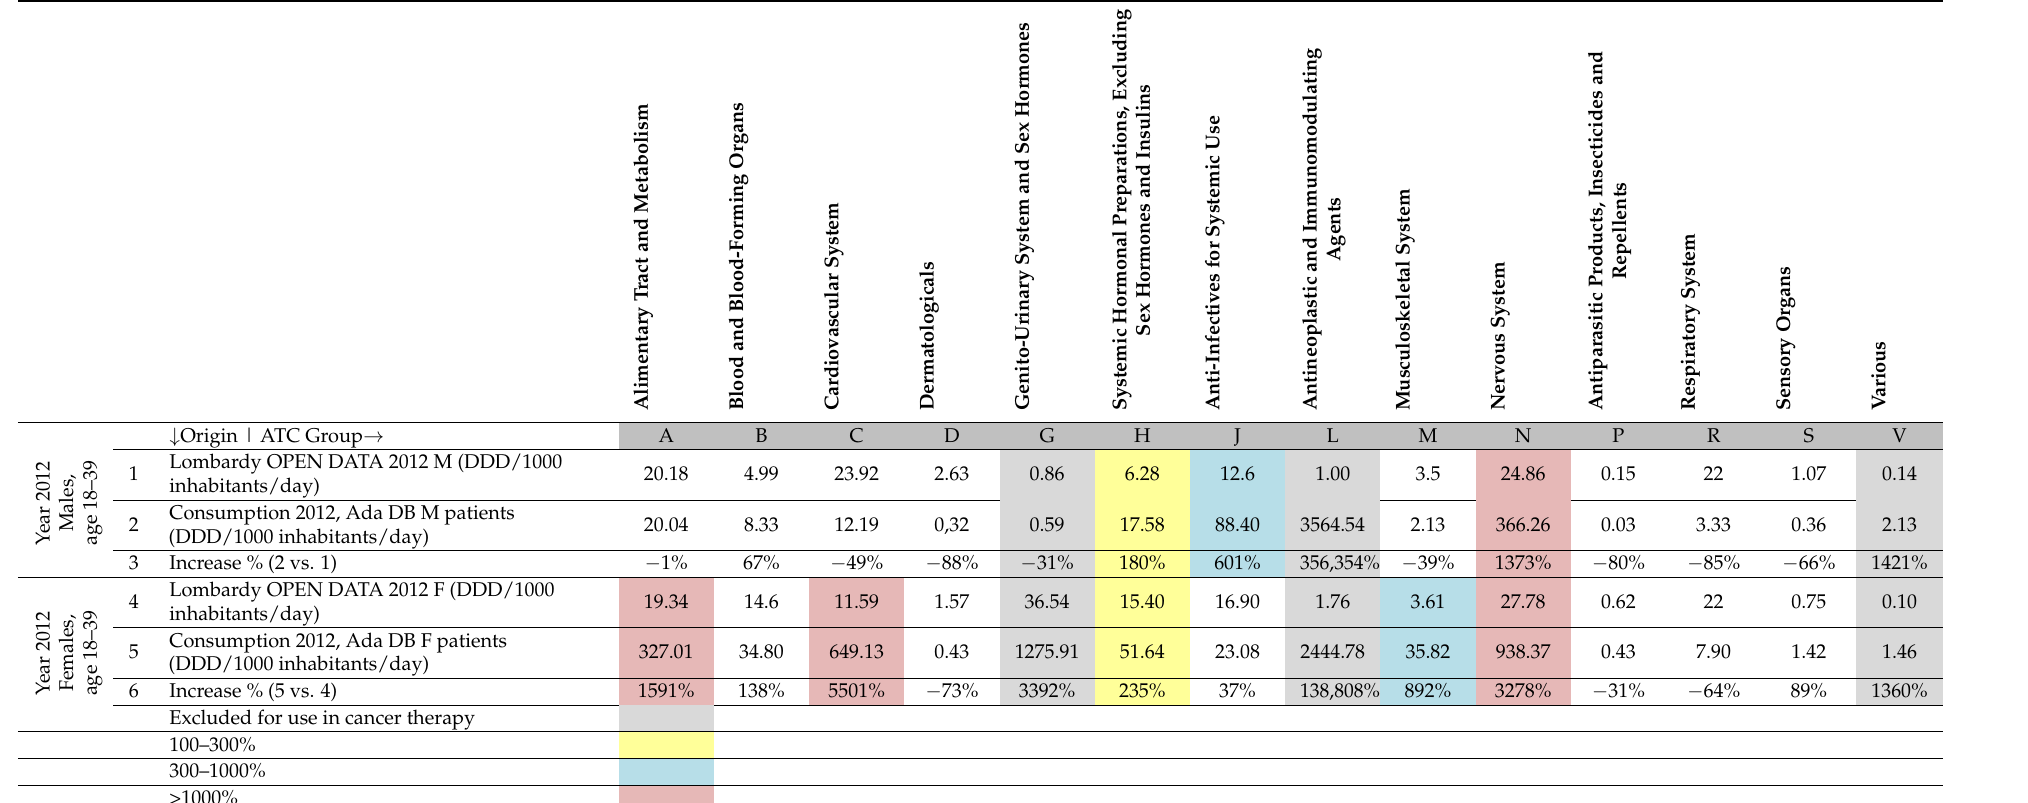
Table 4. Comparisons between Ada cohort and Lombardy Open Data for ATC groups in